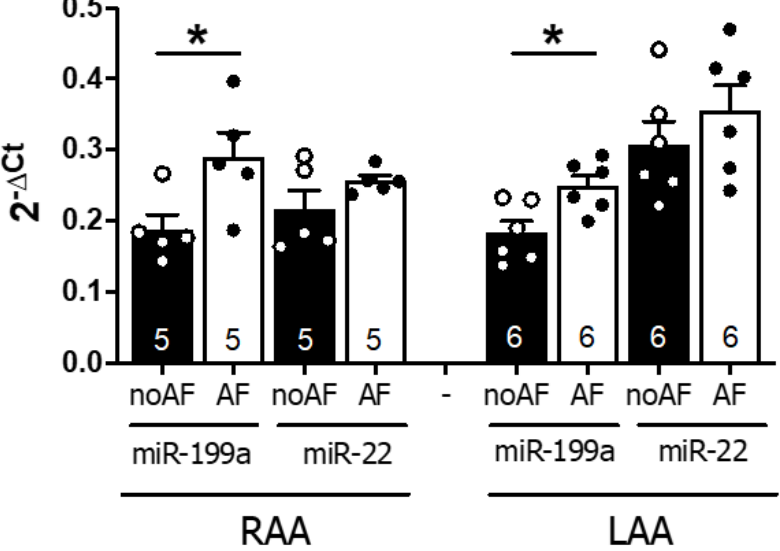
Figure 1. MicroRNA determination in human left and right atrial appendages. Expression levels of miR-199a-5p and miR-22-5p of AF patients (white columns) compared to those in sinus rhythm (no-AF, black columns). Scatter dot blots represent each individual patient, and the number within the column represents the total of independent experiments performed. * p < 0.05, RAA: right atrial appendage, LAA: left atrial appendage.